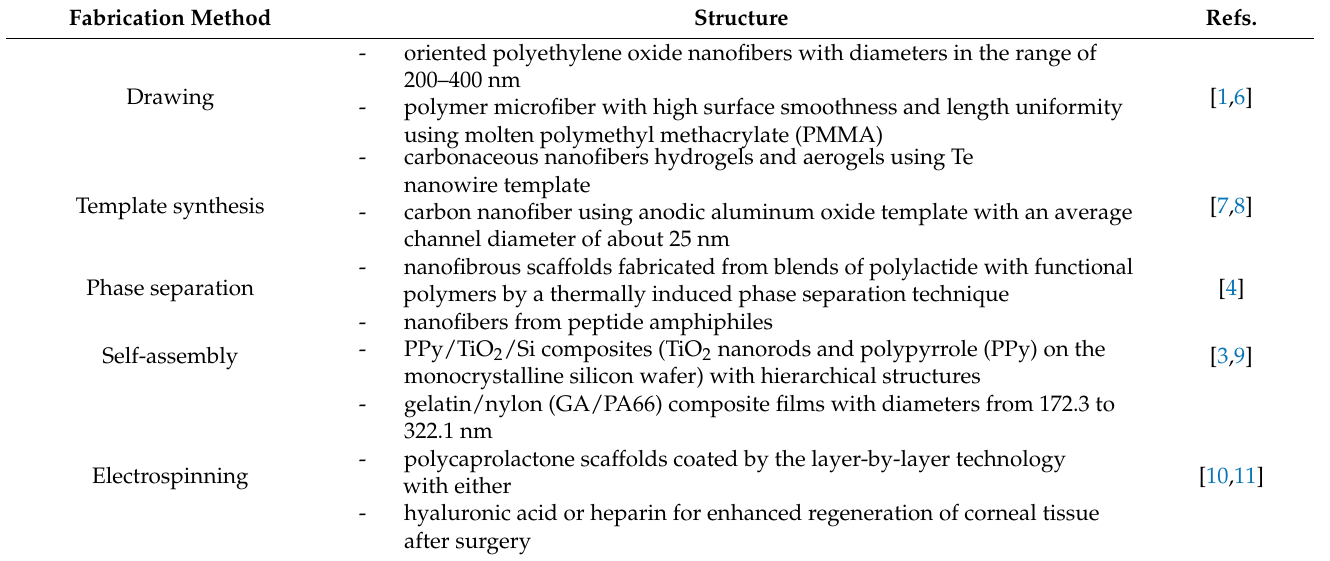
Table 2. Application examples for each method of polymer nanofiber